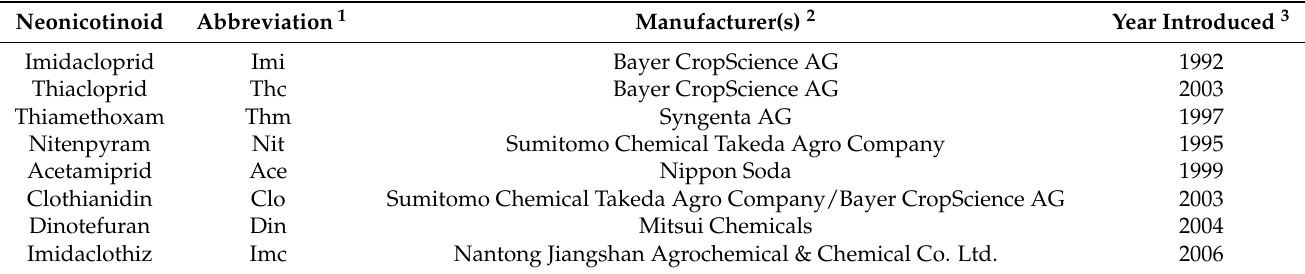
Table 1. Commercially available neonicotinoids.